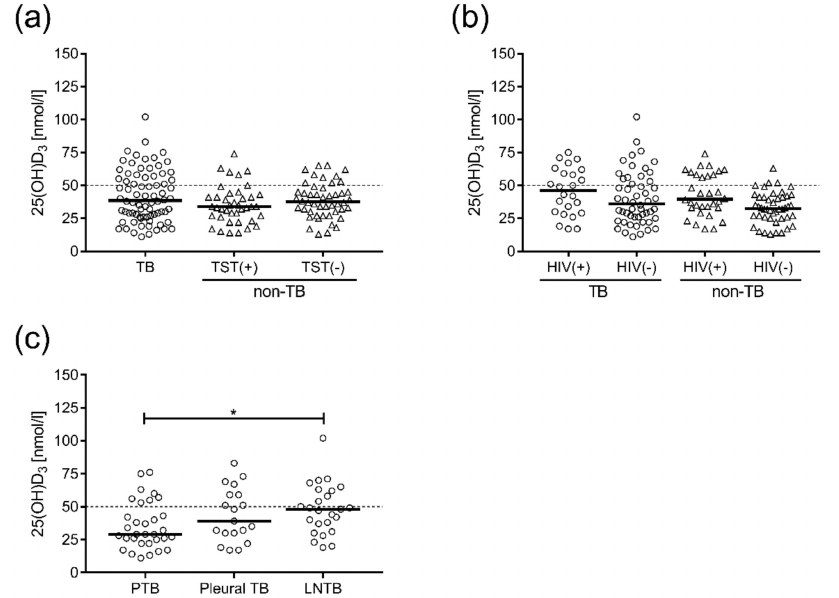
Figure 2. VitD 3 levels in subgroups of Ethiopian TB patients and non-TB controls. Concentrations